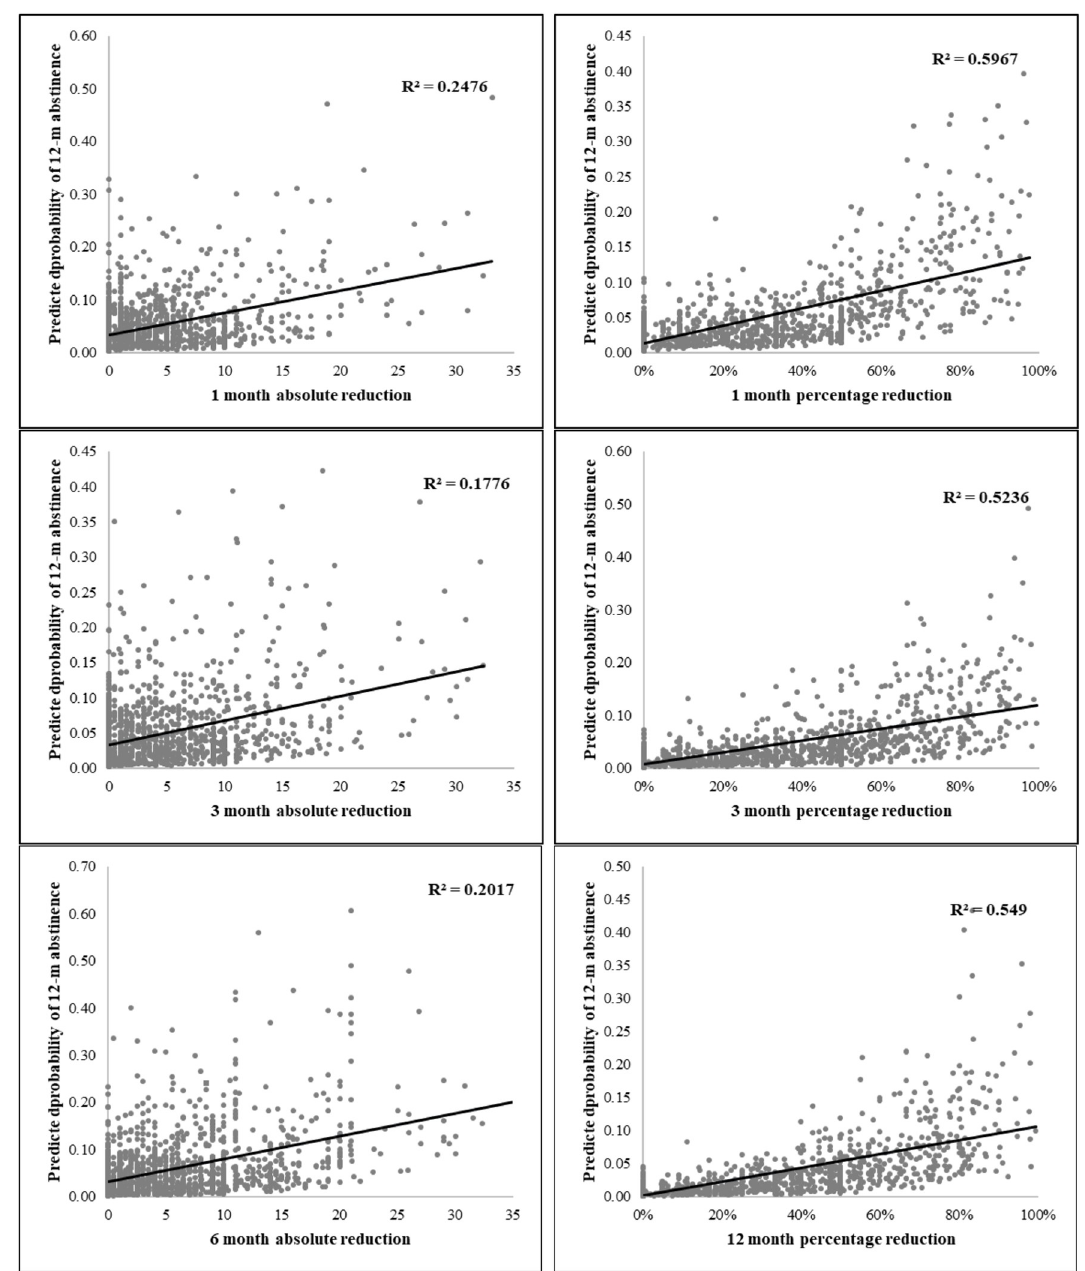
Fig 2. Scatterplot of the predicted probability of 12-month abstinence against the reduction of cigarette consumption at 1-month, 3-month, and 6-month.